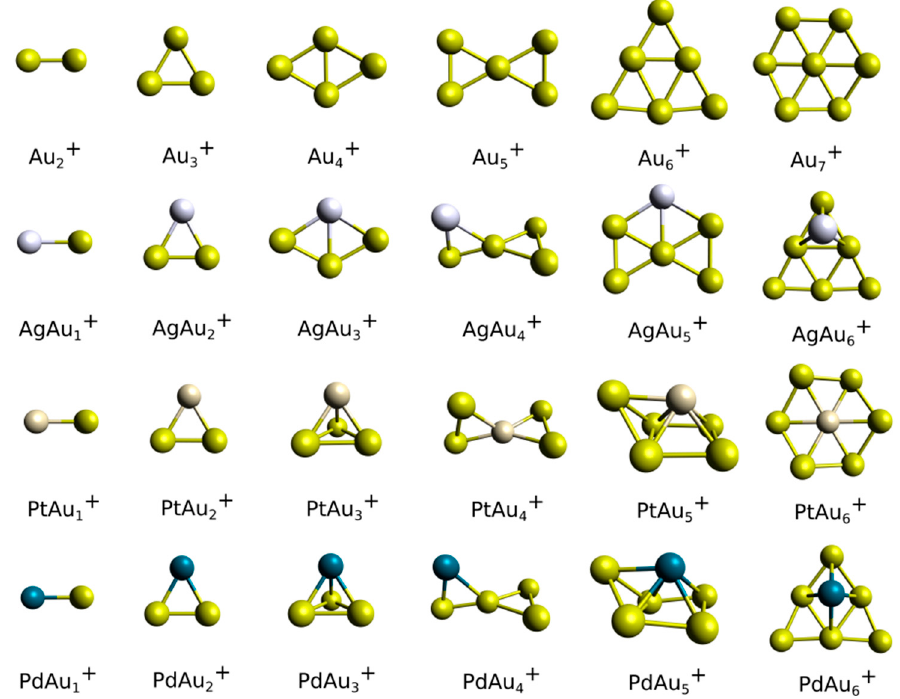
Figure 3. Computed lowest energy structures of Au N + , AgAu N − 1+ , PtAu N -1+ , and PdAu N − 1+ ( N = 2– 7).